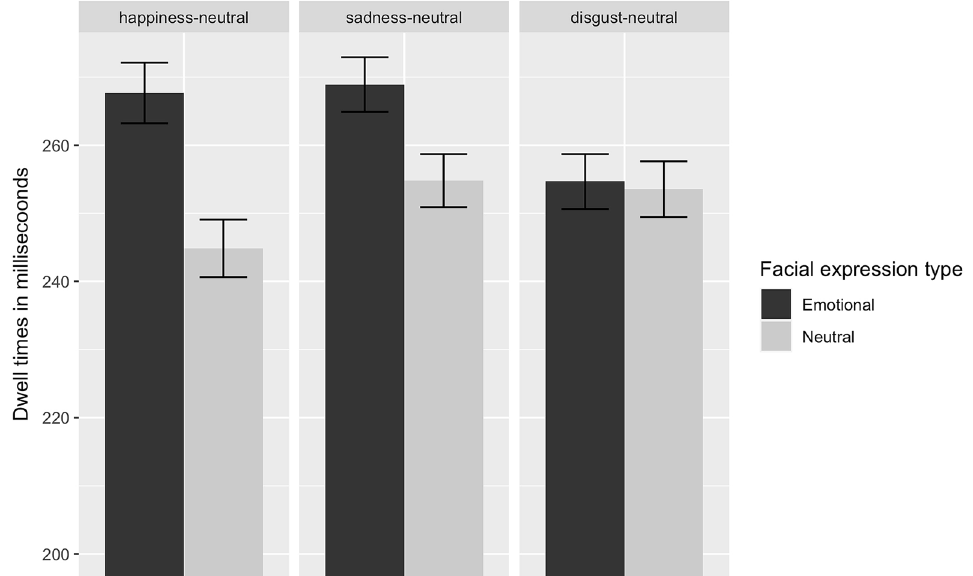
Figure 2. Dwell times on the emotional and neutral facial expressions in ms for happy-, sad-, and disgusted- neutral facial expression pairs. Error bars denote standard